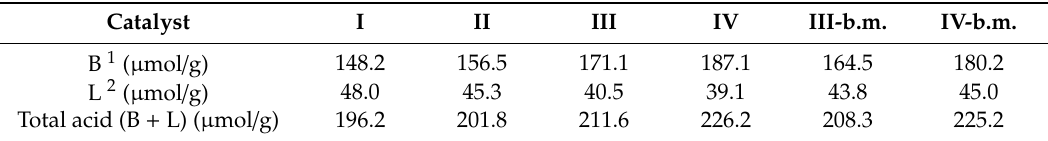
Figure 3. ( a ) Temperature-programmed desorption of ammonia (NH 3 -TPD) profiles of various ZSM- 5 zeolites; and ( b ) infrared spectra of adsorbed pyridine on various ZSM-5 zeolites at a desorption temperature of 150 °C. Table 2. Results for the IR spectra of pyridine adsorbed on the di ff erent ZSM-5 zeolites after desorption at 150 ◦ Table 2. Results for the IR spectra of pyridine adsorbed on the different ZSM-5 zeolites after desorption at 150 °C.